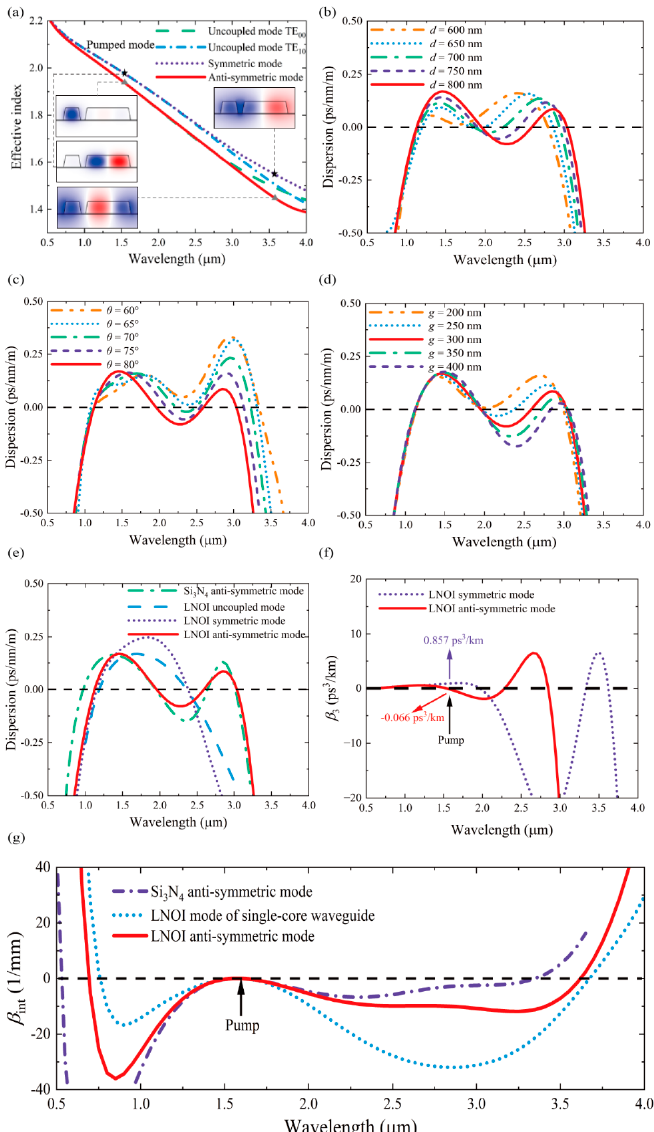
of the coupled waveguides are chosen as H = 0.85 µ m, d = 0.8 µ m, θ = 80 ◦ , w 1 = 0.9 µ m, w 2 = 2.8 µ m, and g = 0.3 µ m.